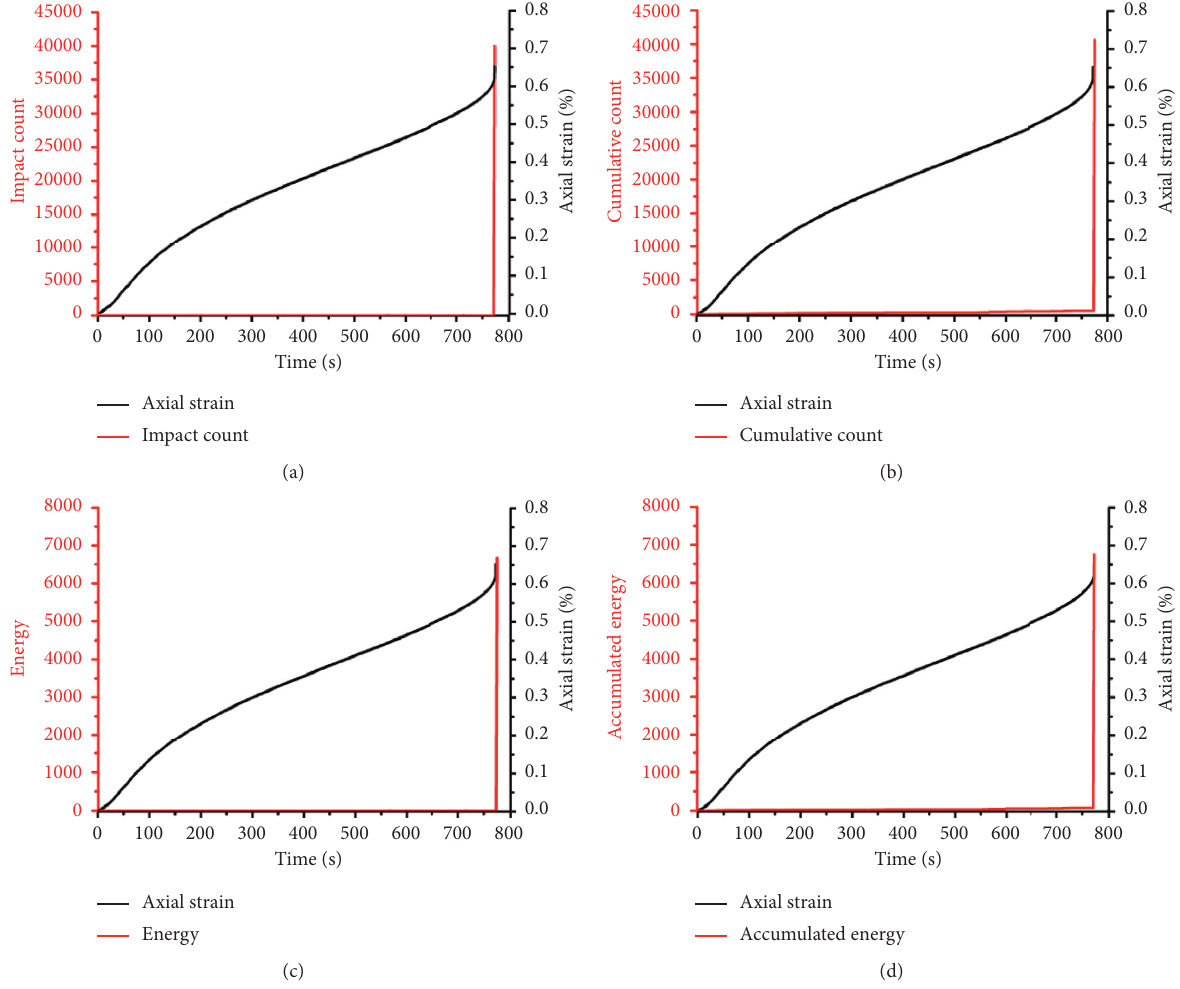
Figure 7: Deformation and acoustic emission characteristics of C-10-1 sample. (a) The curves of ringing count and axial strain of C-10-1 sample with time. (b) The curves of cumulative ringing count and axial strain of C-10-1 sample with time. (c) The curves of energy and axial strain of C-10-1 sample with time. (d) The curves of cumulative energy and axial strain of C-10-1 sample with